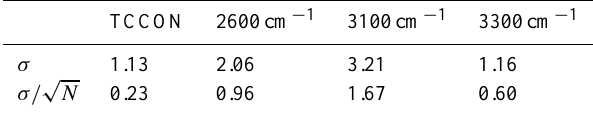
Table 2. Overview over the estimated errors from the different re- trievals. Given are both the mean standard deviation of the daily mean and the mean standard error for N measurements, in ppm.